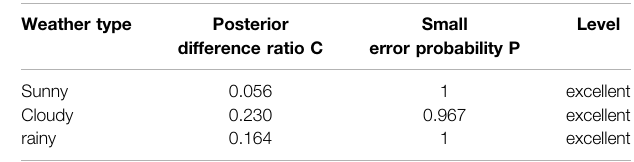
TABLE 4 | Results of the evaluation